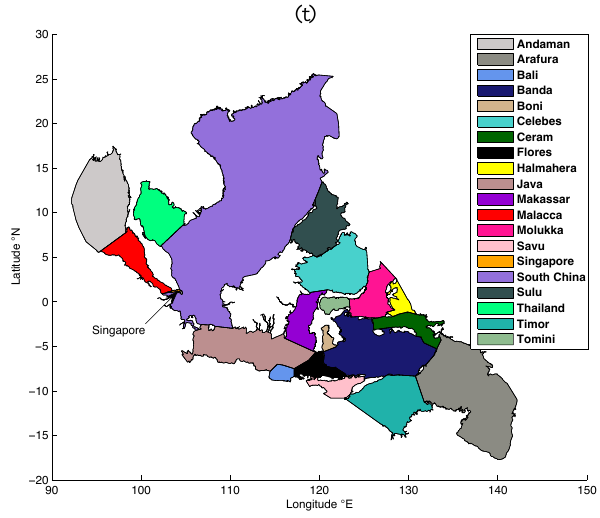
Figure 1. The 20 bodies of water (seas, straits, and gulfs) defined in the Limits of Ocean and Seas (IHO, 1953) for the Southeast Asian sea